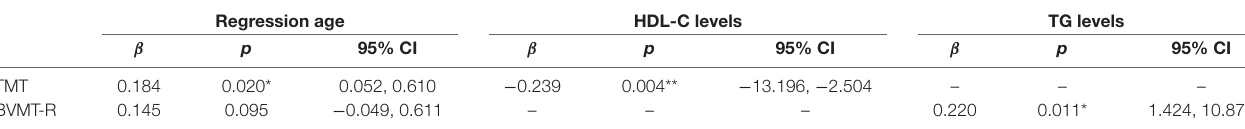
TABLE 4 | Multiple regression on metabolic parameters and cognitive test scores in early-stage schizophrenia